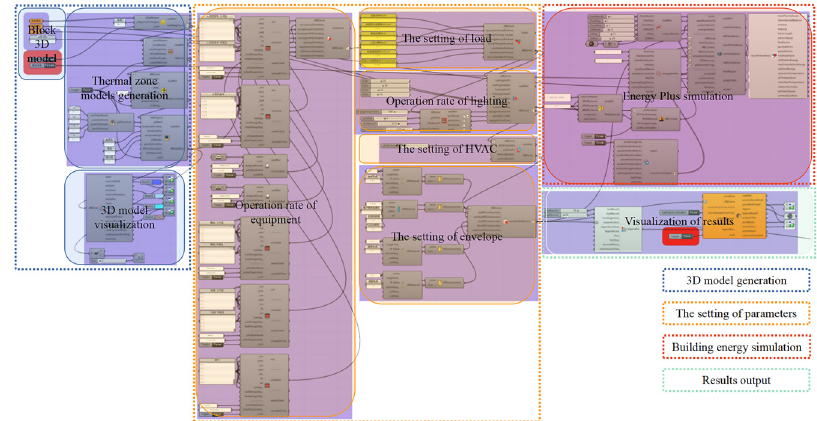
Figure 7. The workflow of building energy simulation.